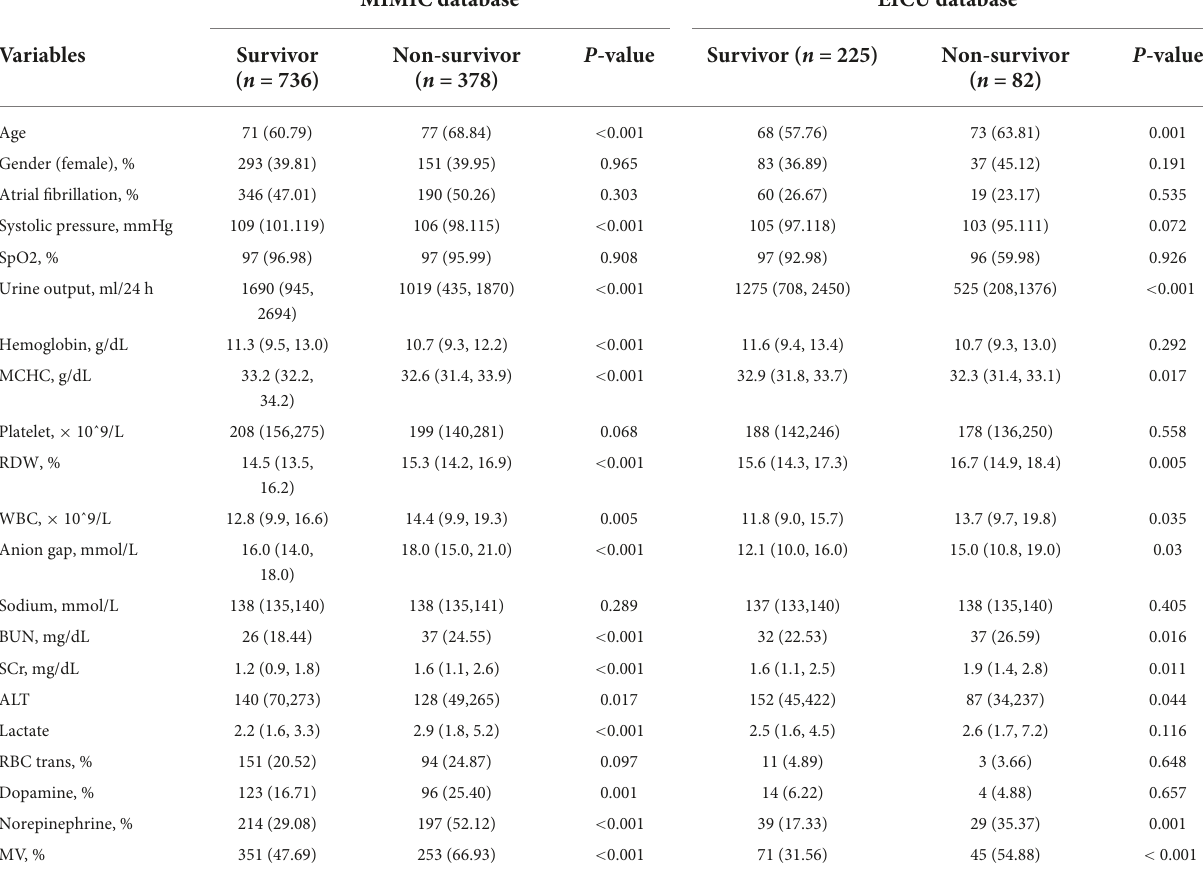
TABLE 1 Characteristics between survivor and non-survivor groups of heart failure patients with hypoxic hepatitis in MIMIC and EICU database. MIMIC database